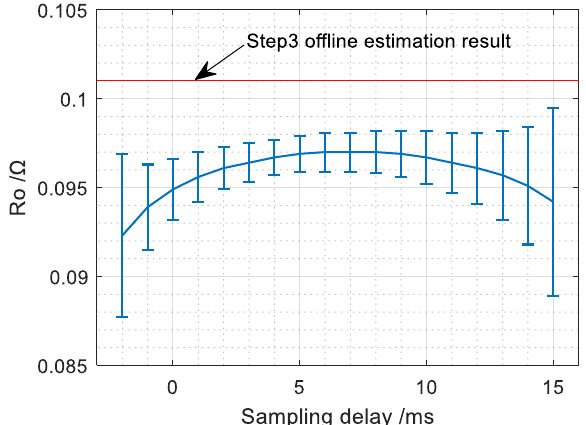
Figure 9. The trajectories of estimated internal resistance with positive sampling delays.